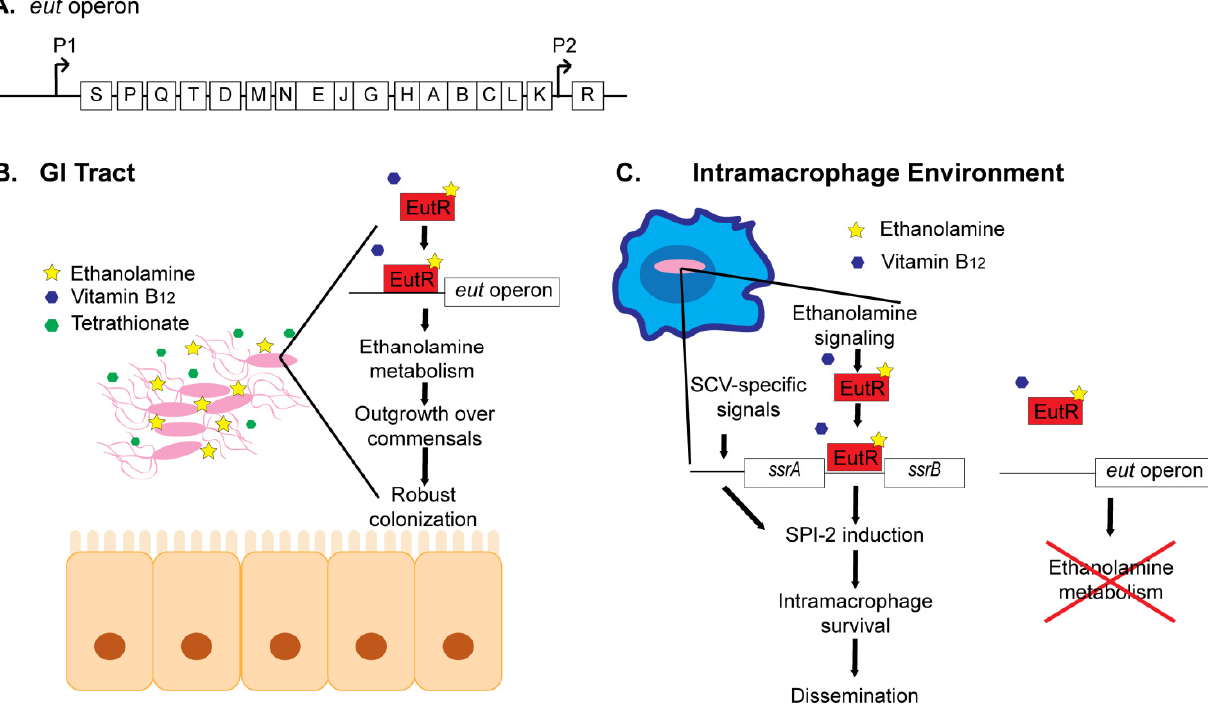
FIGURE 1: Salmonella senses ethanolamine through EutR to recognize the changing host environment and direct metabolism and then virulence. (A) Schematic of the eut operon. (B) In the GI tract, Salmonella - induced inflammation releases the electron acceptor tetrathi- onate. Here, EutR promotes expression of the eut operon, which enables Salmonella to outgrow the resident microbiota and establish infec- tion. (C) Within macrophages, Salmonella relies on ethanolamine signaling through EutR, in conjunction with SCV-containing signals, to in- duce robust expression of SPI-2. This results in increased intracellular survival and subsequent dissemination. In macrophages, ethanolamine metabolism does not provide a growth advantage, and expression of the eut operon is not